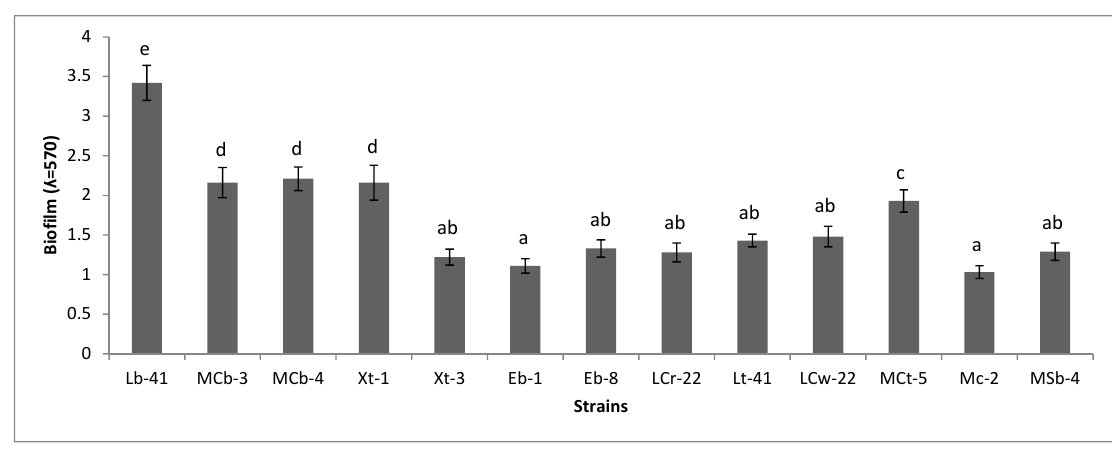
Figure 4. Biofilm formation by some selected purified bacterial strains. Biofilm assay was performed in Tryptic Soy Broth (TSB) medium at 37 °C. Bar represents the mean ± S.E. of three replicates. Different letters on bars indicates significant differences between treatments using Duncan’s multiple range test ( p ≤ 0.05).